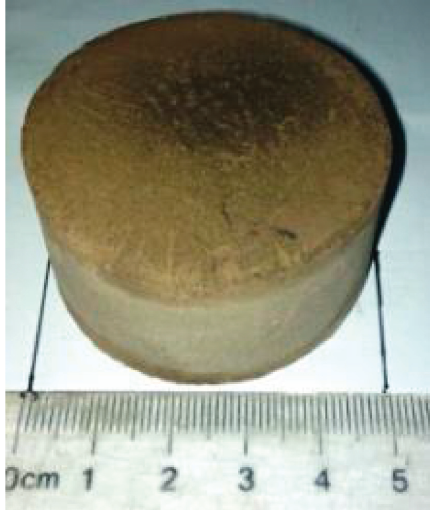
Figure 2: Schematic diagram of the specimen. Table 1: Physical and mechanics parameters of